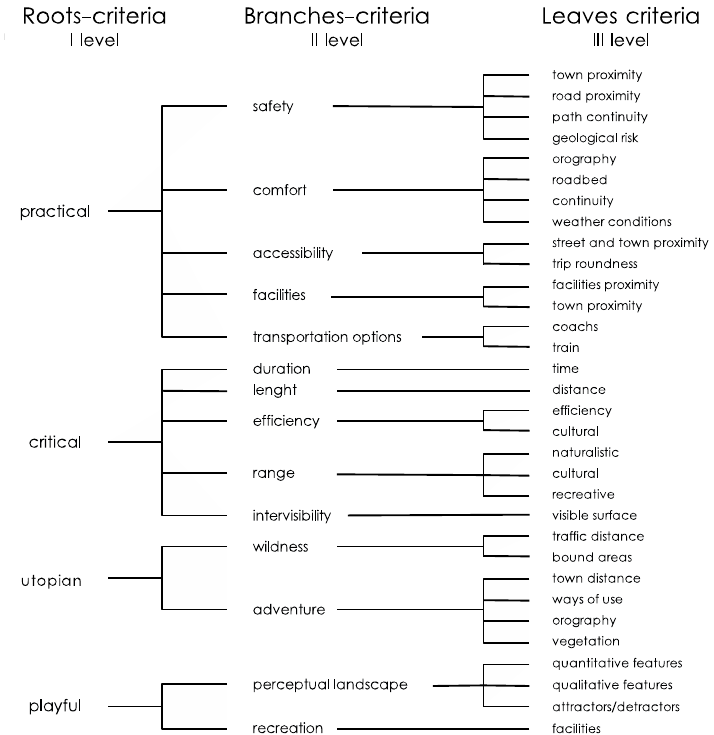
Figure 5. Dendrogram of the axiological representation of the user’s preferences.